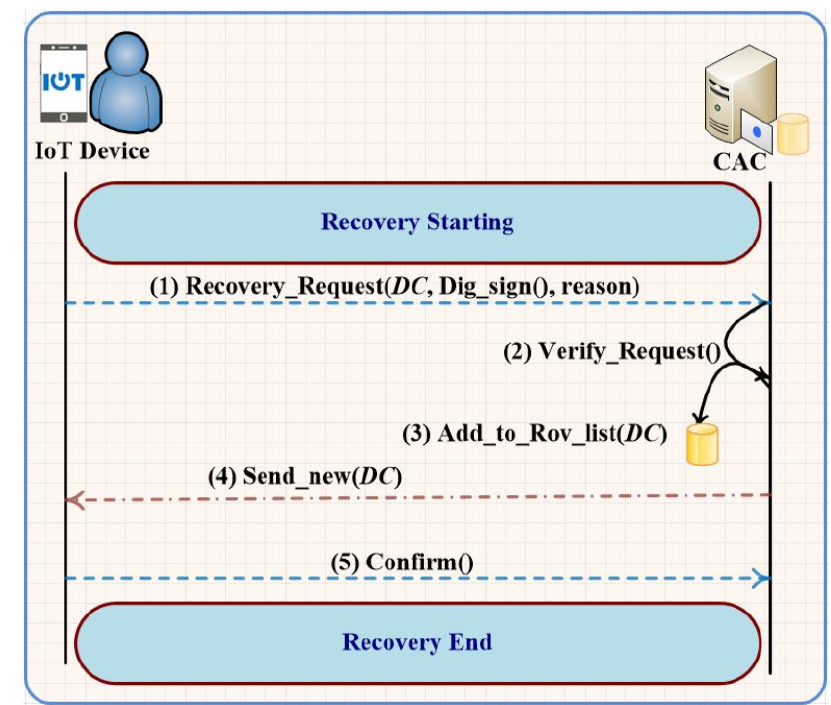
Figure 2. Digital certificate recovery